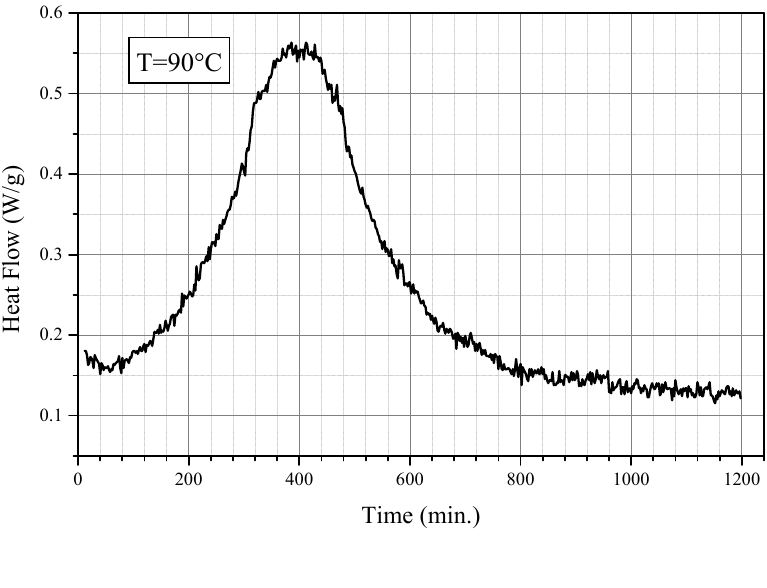
Figure 7. Isothermal test of an ABS powder without adding